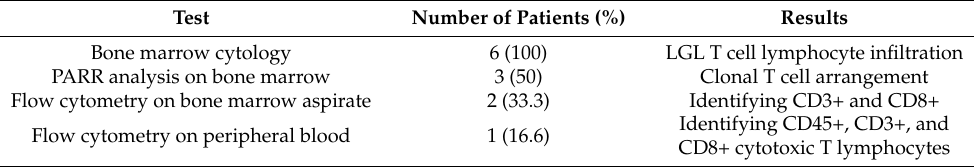
Table 2. Bone marrow, PARR, and flow cytometry results for patients included in the study. Test Number of Patients